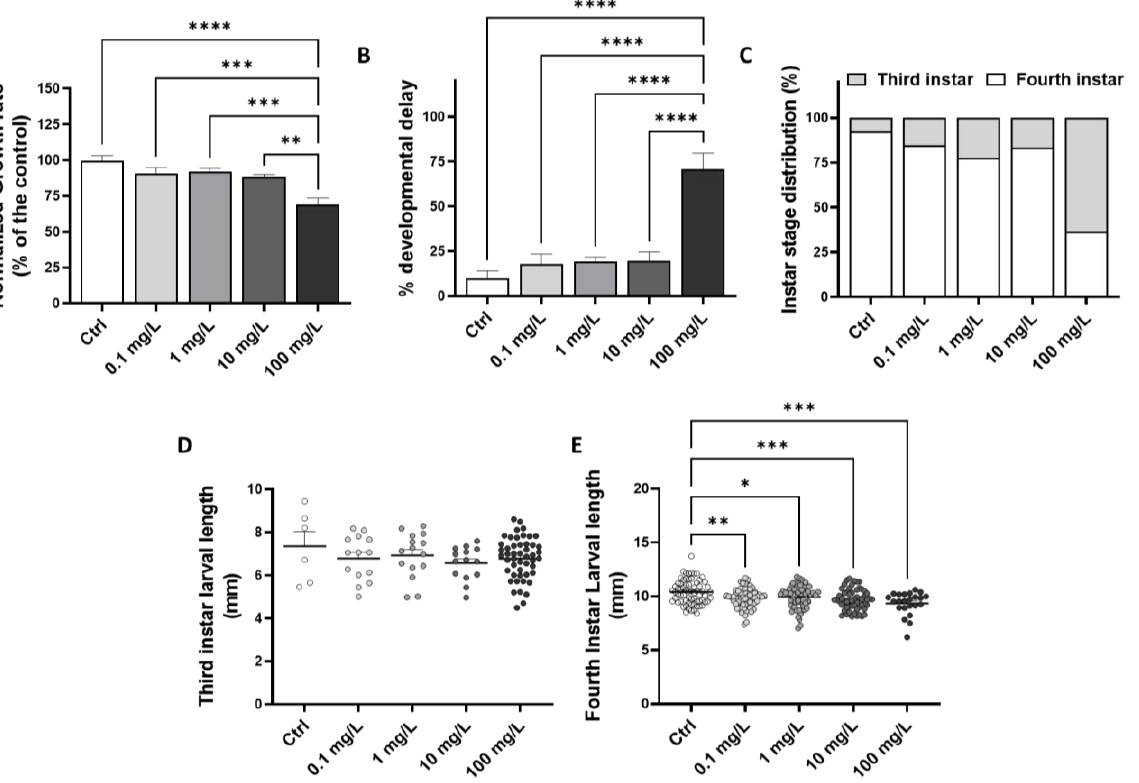
Figure 3. Effects of GO exposure on C. riparius growth rate ( A ), the occurrence of development delay ( B ) and development stage reached at the end of 7 days of exposure ( C ). Length of the larvae from third ( D ) and fourth ( E ) instar measured at the end of the exposure. Each dot represents an individual from the experimental condition. Statistical analysis was conducted using ANOVA, followed by post hoc Tukey test when p < 0.05. “*” indicates significant differences compared to the negative control (Ctrl) (*: p ≤ 0.05; **: p ≤ 0.01; ***: p ≤ 0.001; ****: p ≤ 0.0001).